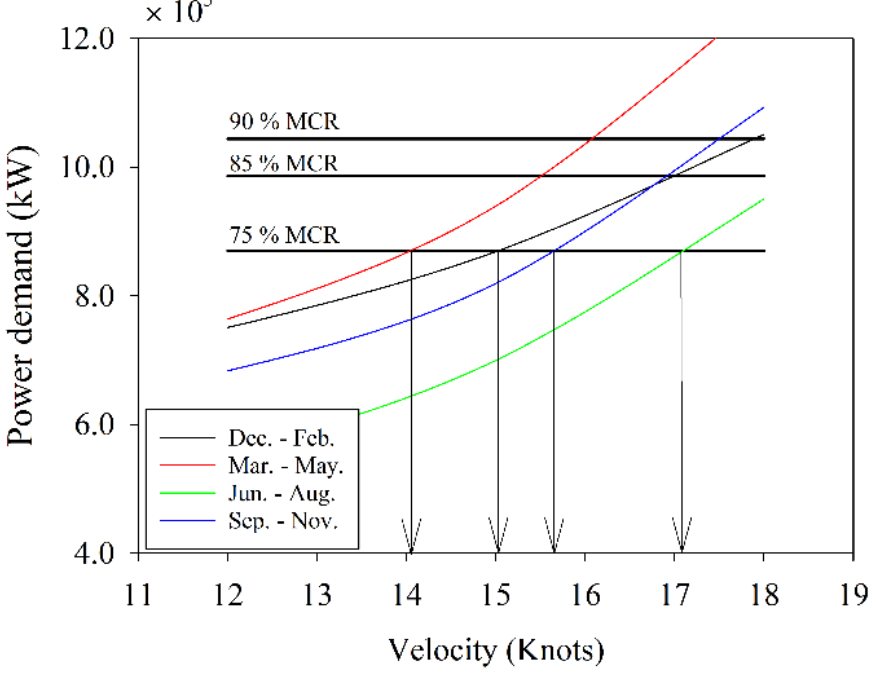
Figure 16. Example of graphical speed loss calculation for one point of route selected in Load Condition 2. Source: Own elaboration.